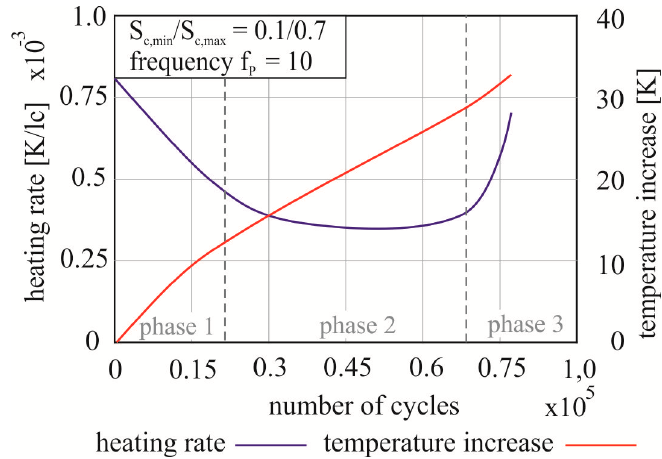
Figure 1. Heating rate and temperature di ff erences of an ultra-high performance concrete (UHPC) specimen for test frequency f P = 10 Hz and relation between lower and upper stress level S c,min / S c,max = 0.1 / 0.7, taken from [24].